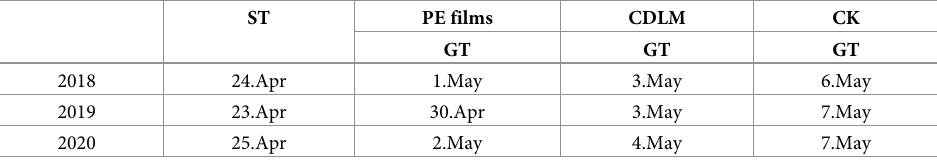
Table 2. The seeding day and the germination day of the silage corn seeds under CDLM, PE films and CK in 2018, 2019, and